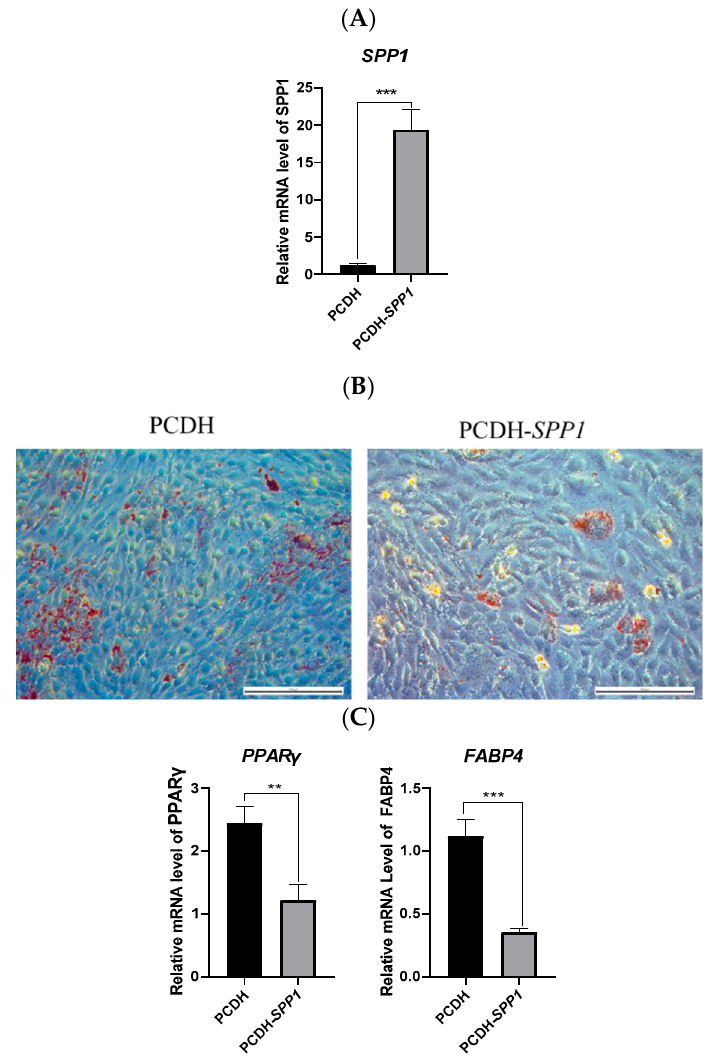
Figure 2. SPP1 overexpression suppressed the adipogenic differentiation of pBMSCs. ( A ) pBMSCs were transfected with the PCDH empty vector (PCDH) or the SPP1 overexpression vector (PCDH- SPP1 ), and SPP1 expression was measured by qRT-PCR. ( B ) The transfected pBMSCs were induced to differentiate for 14 days and lipid droplets were observed by Oil Red O staining (bar = 200 µ m). ( C ) Adipose marker factors PPAR γ and FABP4 mRNA expression of pBMSCs harboring PCDH or PCDH- SPP1 were detected by qRT-PCR. ***, p < 0.001; **, p < 0.01.